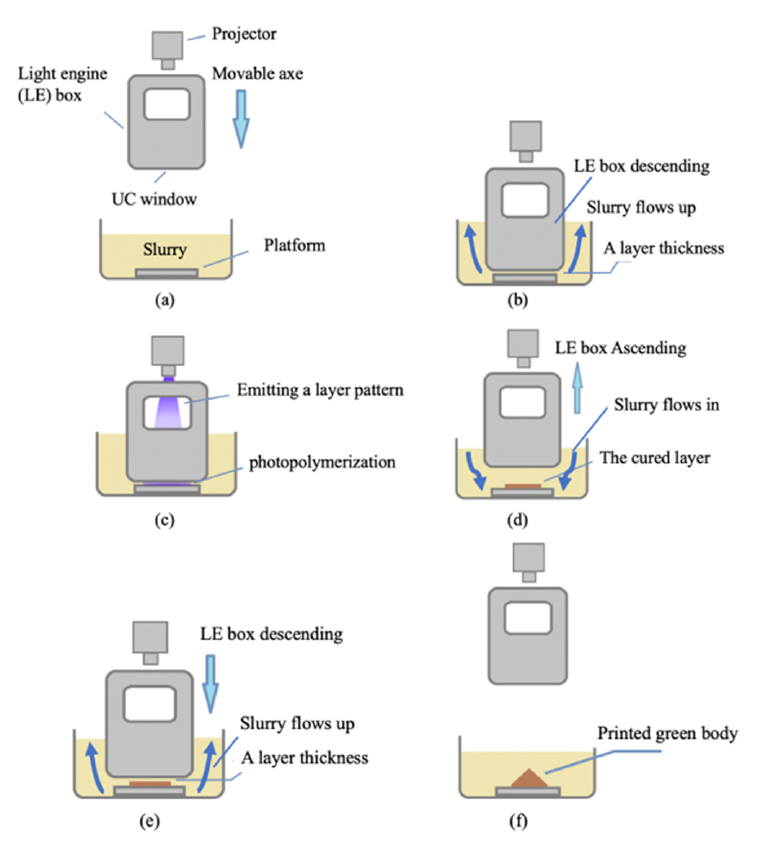
in the bottom-up method. Separation force/peeling force between printing product and vat surface is a common reason for the failure [22]. To lower the possibility of this failed printing, a novel submersion-light printing method is proposed. This method reverses the bottom-up approach. The build platform that usually moves up and down layer by layer becomes steady; on the other hand, the light source that is typically steady becomes moving up and down, layer by layer. Not just moving, the light source is submerged into the vat. Figure 1 shows the printing method for the proposed process of 3D printing with submersion-light apparatus. It uses a movable projector with an upper constraint (UC) window as a light engine (LE) box, as shown in Figure 1a. The UC window consists of highly transparent glass and a soft interface for departing. The platform is mounted on the bottom of the slurry vat. Figure 1b shows that the slurry flows when the LE box submerses itself in the slurry, and the UC window maintains the layer thickness distance between the platform. The LE box emits the layer pattern transmitted by light with a wavelength of 405 nm onto the slurry between the UC window and the platform to induce photopolymerization, as shown in Figure 1c. The cured layer bonds with the platform and adheres to it. At the same time, the LE box ascends because the soft interface on the UC window allows an elastic deformation to depart, and the gravity of the cured layer causes separation, as shown in Figure 1d. As the LE box ascends, the slurry flows, so the ceramic powder is suspended, and the slurry does not separate or form sediment during the printing process. Figure 1e shows the LE box submerged in the slurry. The slurry flows upward, and a layer thickness distance is maintained for the next layer of printing. The green body is produced by repeating (e), (c), and (d) until all layers are printed, as shown in Figure 1f.